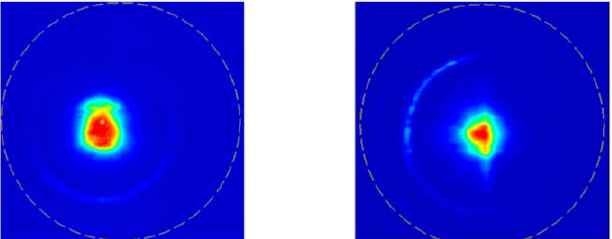
Figure 15. O-rings in the far field of Ti:Sapphire laser with the single-mode pump. The right pattern was recorded when AR coatings at the crystal were damaged. Light scattering at damaged areas resulting from increased intensity of O-rings. Reprinted with permission from ref. [18]. Copyright 2019 © The Optical